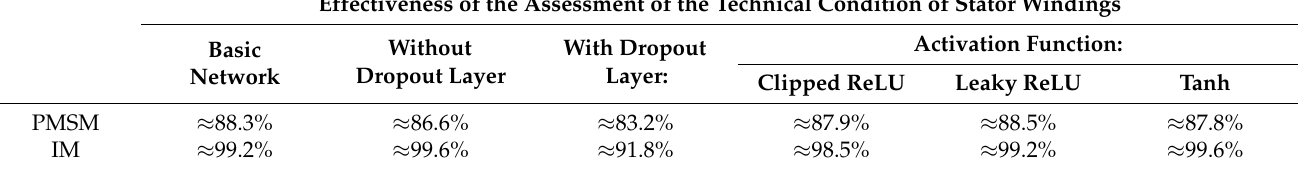
Table 4. Influence of CNN structure parameters on the precision of responses to test data.